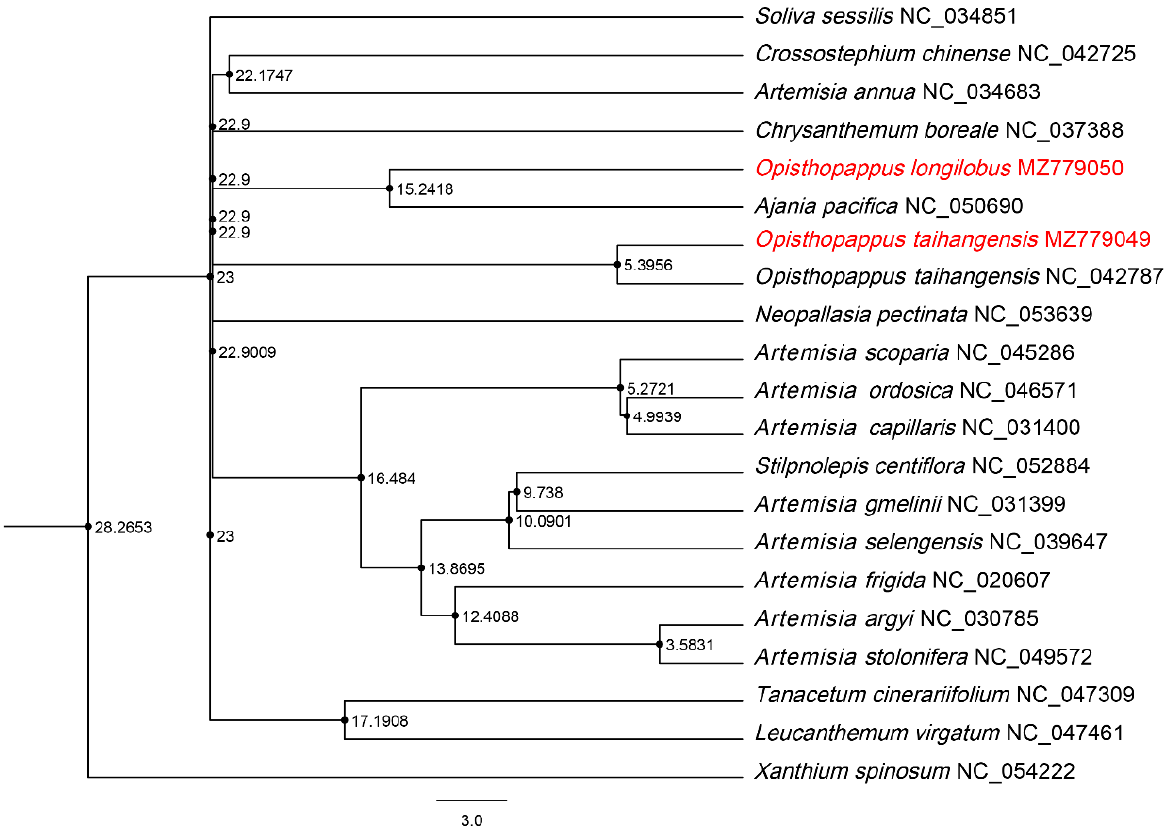
Figure 5. Divergence time estimation based on subtribe Chrysantheminae.